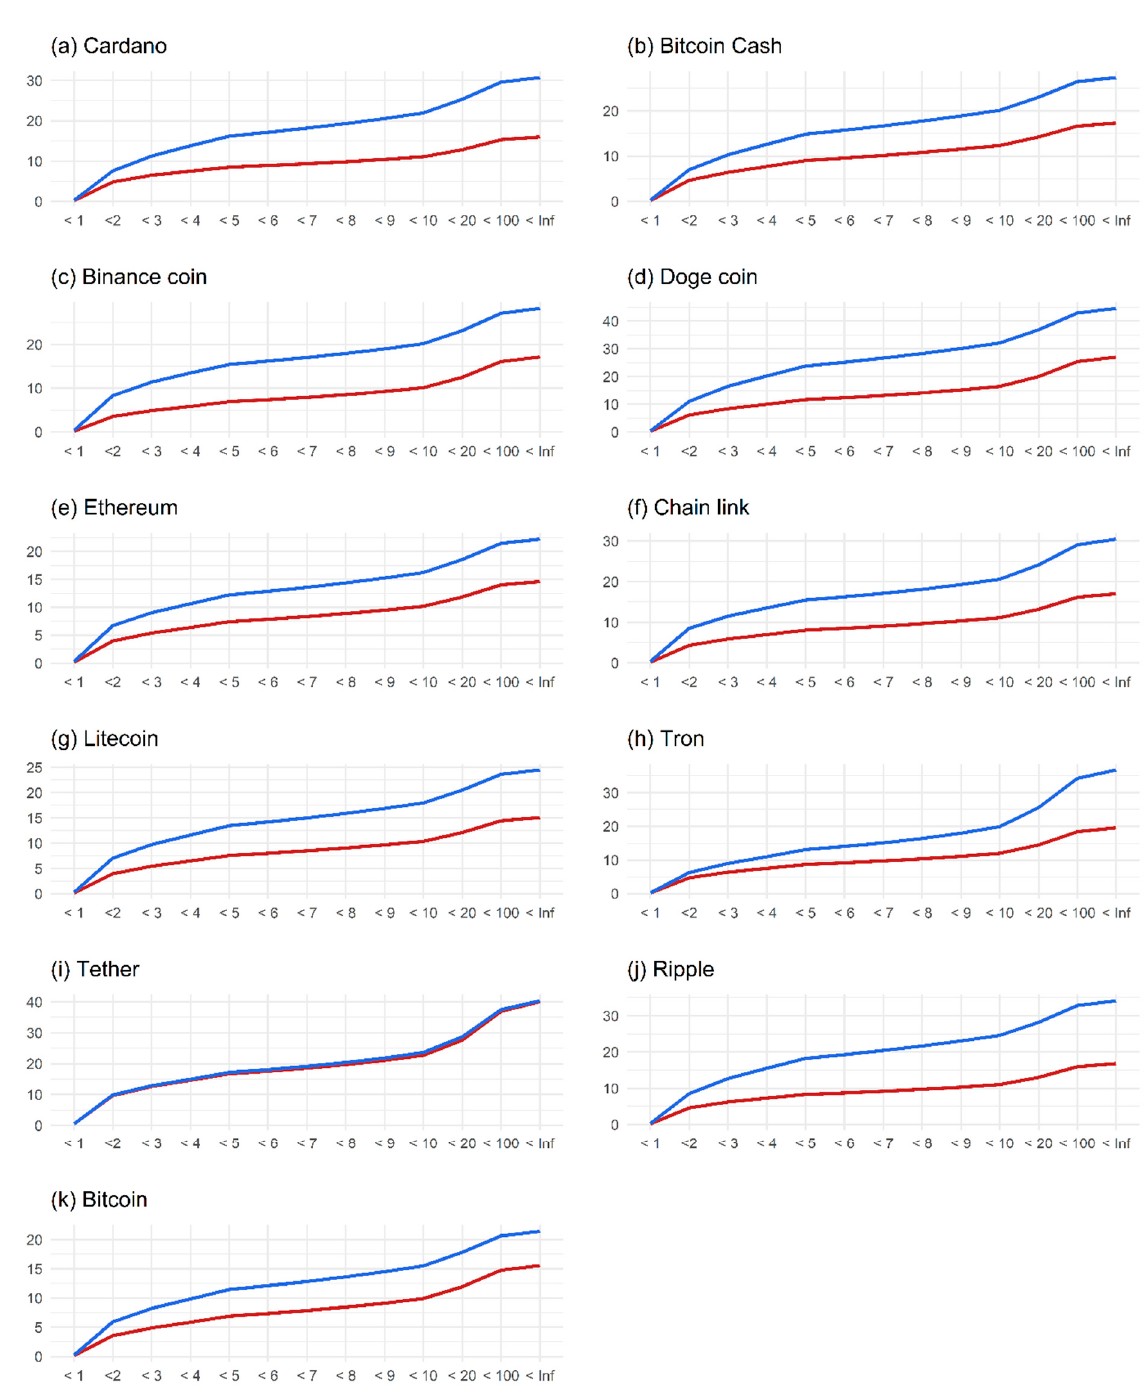
Figure A1. Short- and long-term volatility spillover from altcoins to themselves. Note: See note to Figure 3.